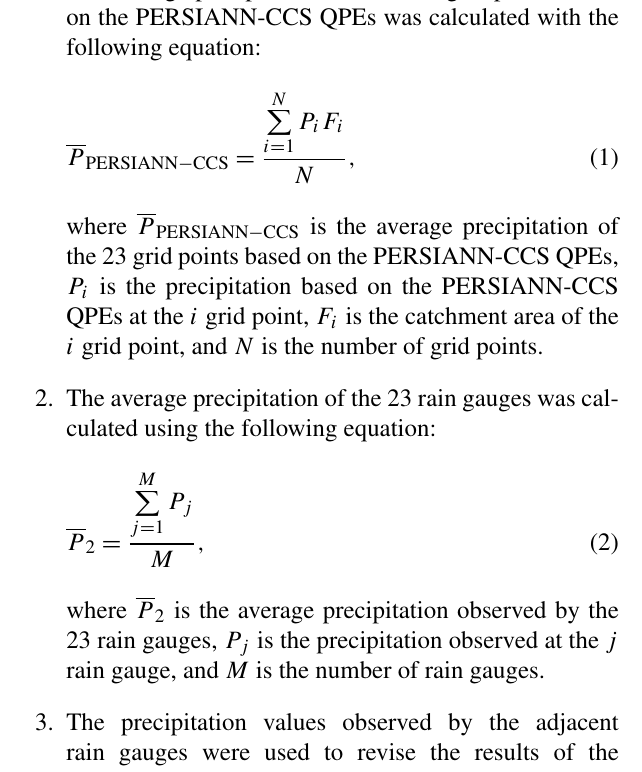
Table 1. Precipitation pattern comparison of the two precipitation products.